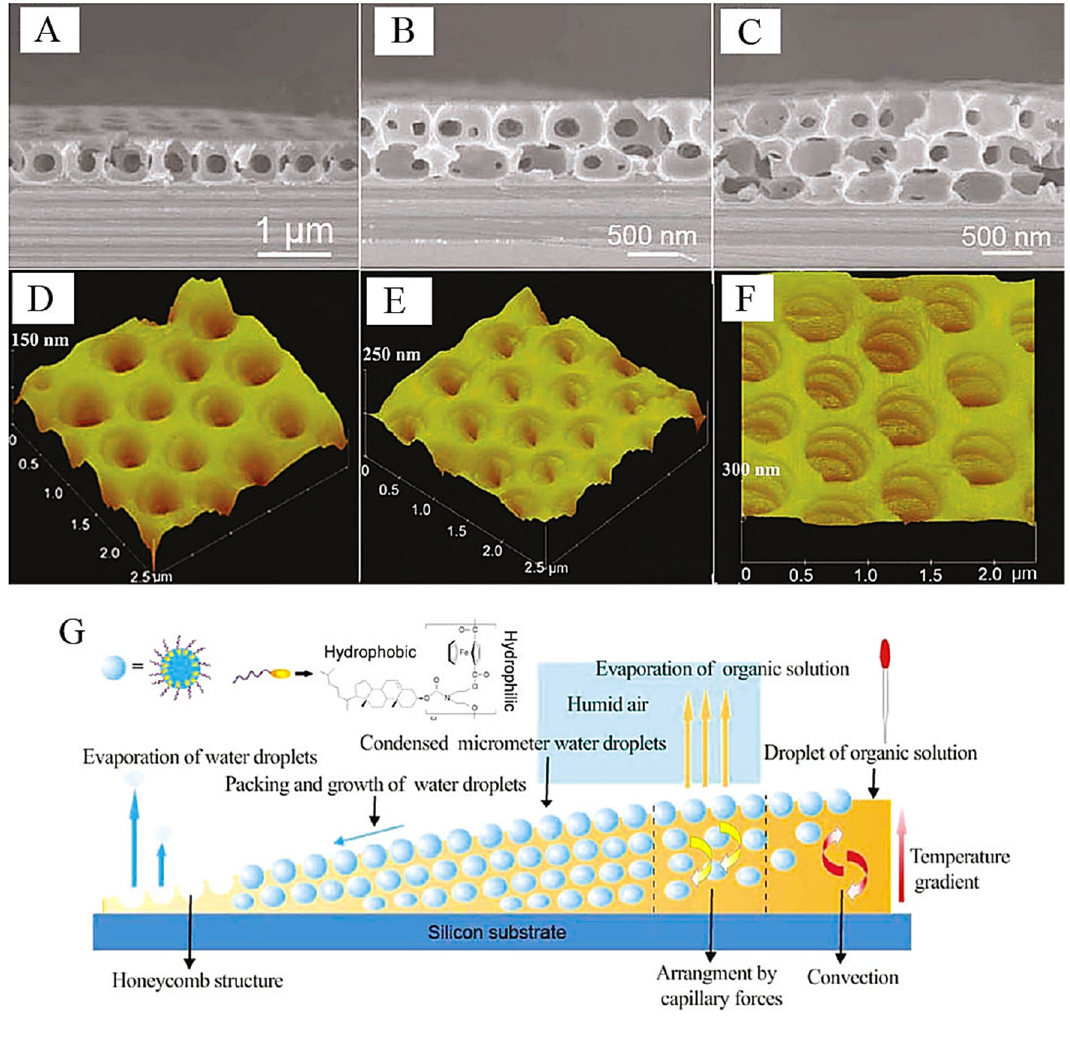
Figure 5. SEM ( A – C ) cross-section images and AFM ( D – F ) 3D observations of the monolayer ( A , D ), bilayer ( B , E ), and trilayer ( C , F ) honeycomb films from 0.6 mg/mL oligomer 1 /CS 2 mixed solution on silicon substrates. ( G ) The schematic drawing of the formation mechanism of honeycomb structures from single-layer to multilayer arrays of the pores on a silicon substrate with ferrocenyl-cholesterol as the building unit, with copyright permission from